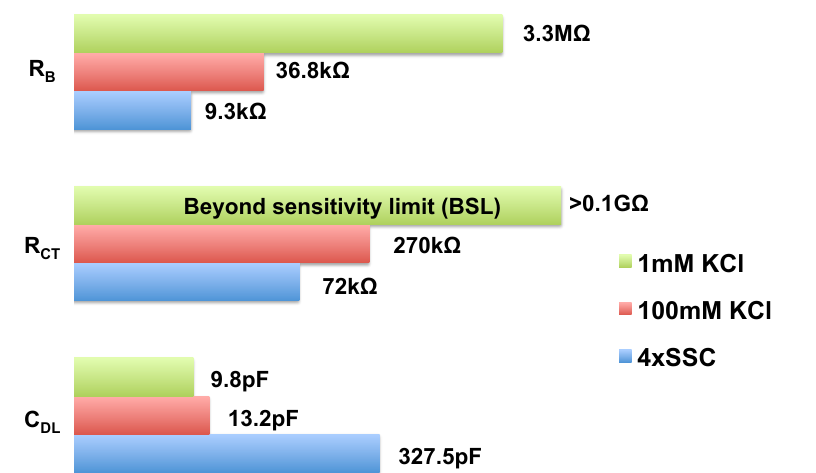
Figure 15. Equivalent circuit parameters for three different biological buffers. The experiments were done using on-chip electrodes.